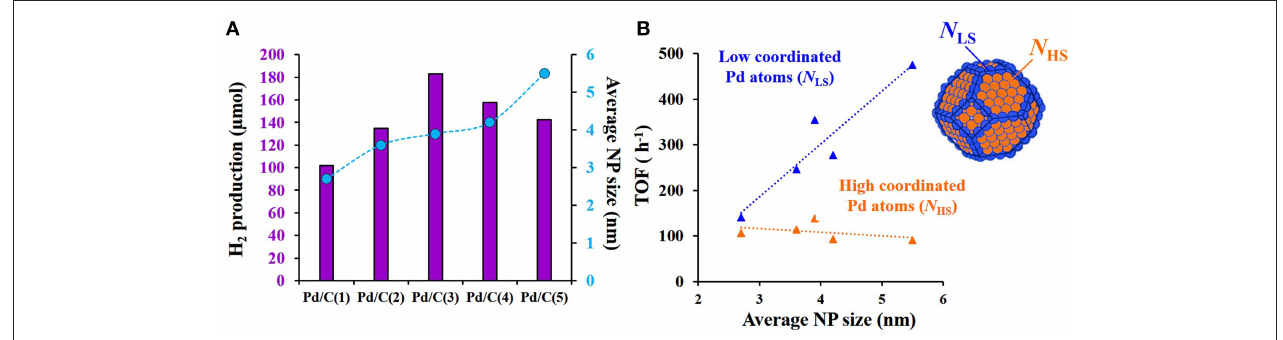
FIGURE 2 | (A) Relationship between H 2 production after 3h of reaction at 30 ◦ C and the average Pd nanoparticles (NP) size; (B) Normalized TOF values calculated on the basis of high-coordinated (HC) and low-coordinated (LC) as a function of the average Pd NP size. Adapted with permission from Navlani-García et al. (2016b). Copyright 2016 Wiley.